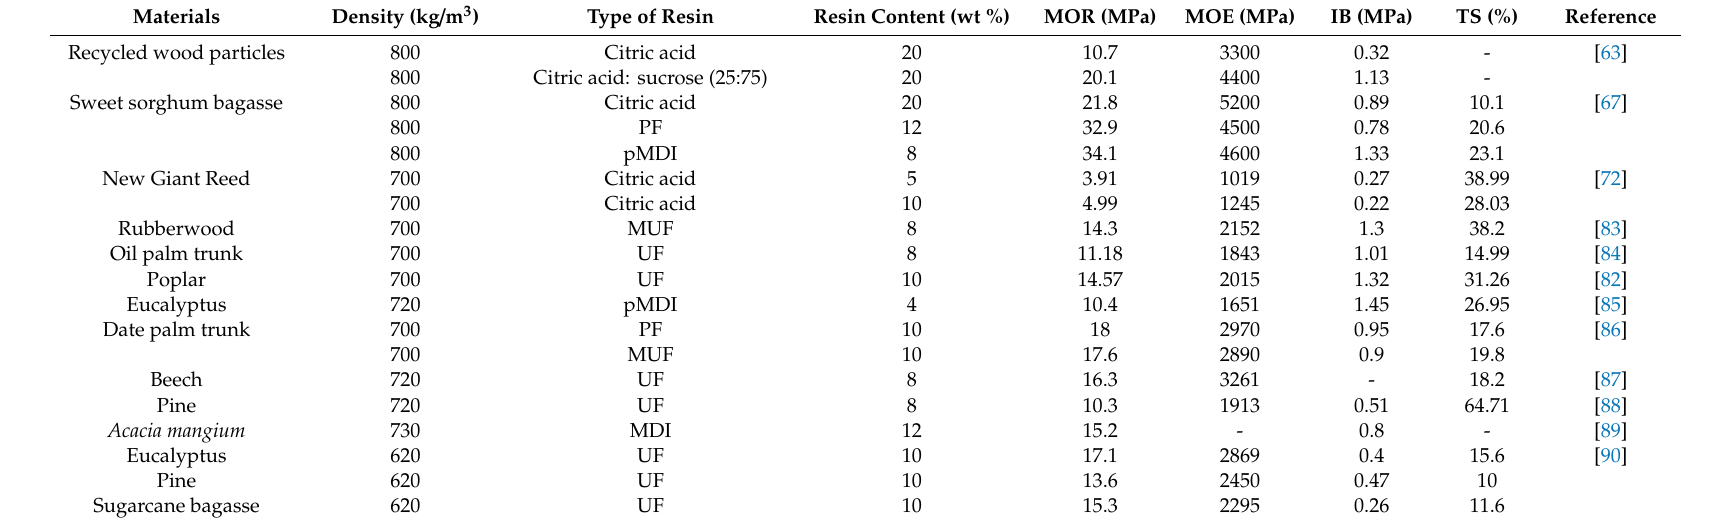
Table 4. Comparison between citric acid bonded particleboard and particleboard bonded with conventional